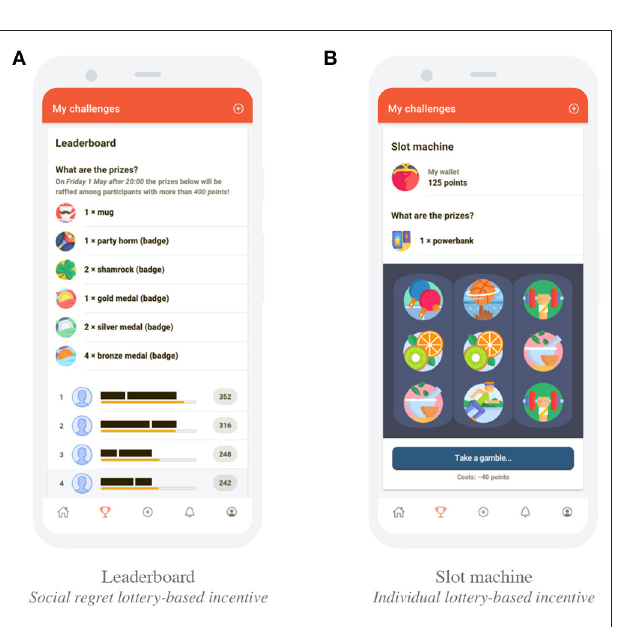
FIGURE 1 | Display of the social regret lottery-based incentive and individual lottery-based incentive. See ( 23) for additional visualizations of